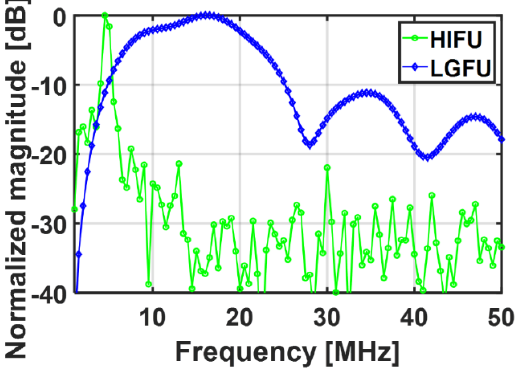
Figure 5. Normalized frequency spectra of the HIFU and the LGFU (the detector bandwidth effect was included for both cases).